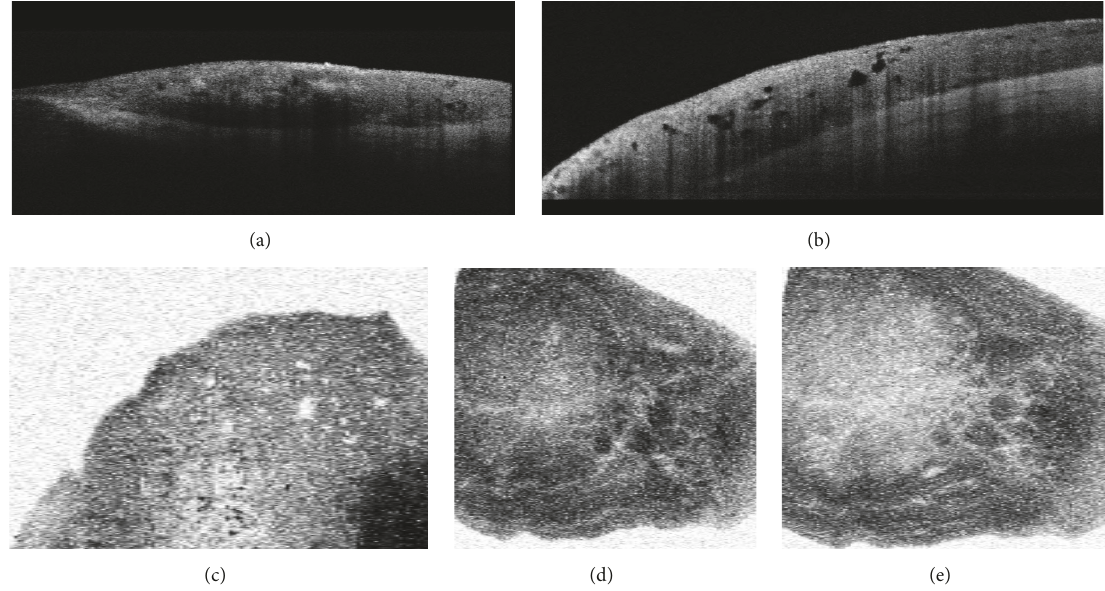
Figure 2: Results of anterior segment optical coherence tomography of conjunctival nevus. B scan images (a, b) show distinct posterior borders of various parts of the lesion with variegate degree of posterior shadowing and with numerous intralesional cystic lesion (b); C scans (c–e) can detect intralesional cysts (c) and intralesional vessels (d,